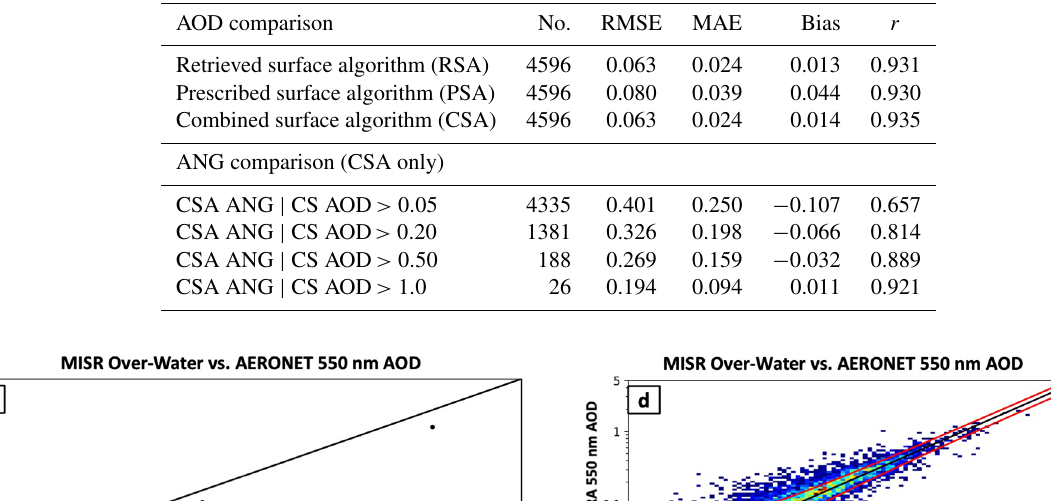
Table 5. MISR RA vs. AERONET direct-sun statistics over water. Same as Table 3, except for MISR RA over water.